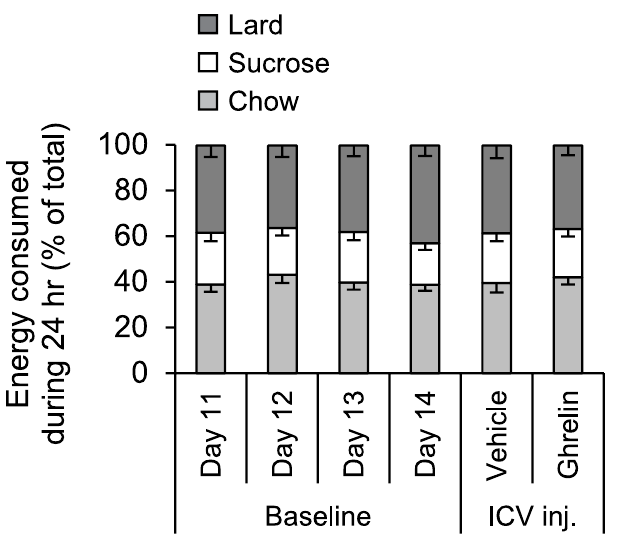
Fig 1. Stability of daily food selection. Stability of daily (24 hr) food selection in rats (n = 18) offered an ad libitum free choice diet of normal chow, 1 g sucrose pellets and lard (a saturated animal fat). Data are shown for the last 4 baseline days (day 11 – 14) prior to ICV injection, and for the injection days in which 2 μ g ghrelin or aCSF were administered. The data are expressed as mean ± SEM kcal consumed as % of daily total kcal